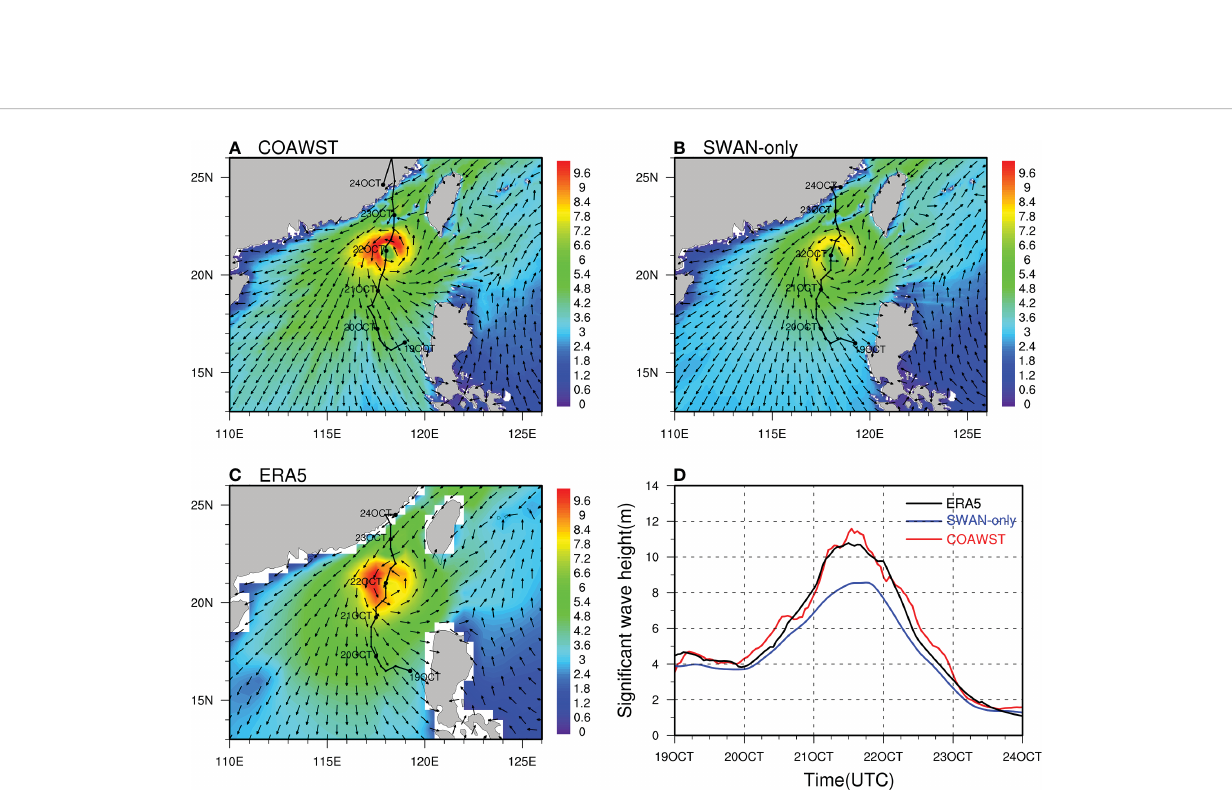
FIGURE 9 Comparison of signi fi cant wave height (shaded, units: m) and wave propagation direction (vector) between simulations of (A) COAWST, (B) SWAN- only, and (C) ERA5 reanalysis at 00 UTC on 22 October. The track (solid black line) in (A) is derived from COAWST simulation, and (B, C) is derived from ERA5 reanalysis. (D) Comparison of the changes of signi fi cant wave height (H s ), the average value in the region with high H s (larger than 7.8m in A ) to the left side of TC center at 00 UTC 22